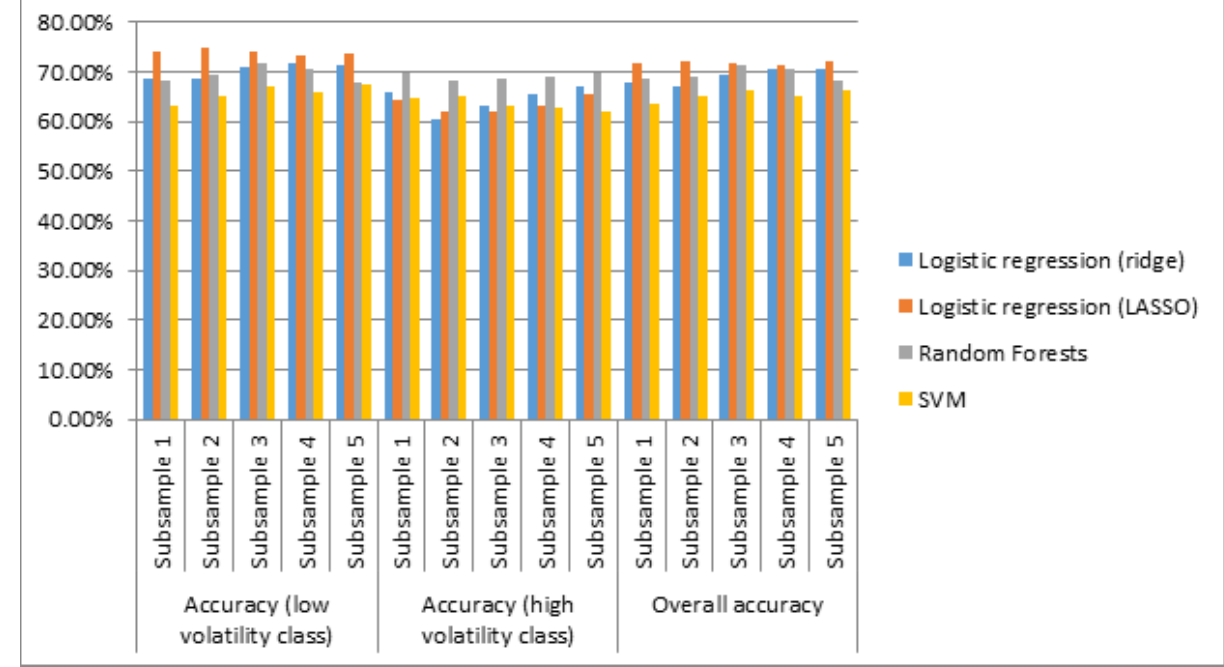
Figure 2. Prediction performance using all 132 features (graphical representation of <xref ref-type="table" rid="table1">Table 1</xref>). LASSO: least absolute shrinkage and selection operator; SVM: support vector machines.